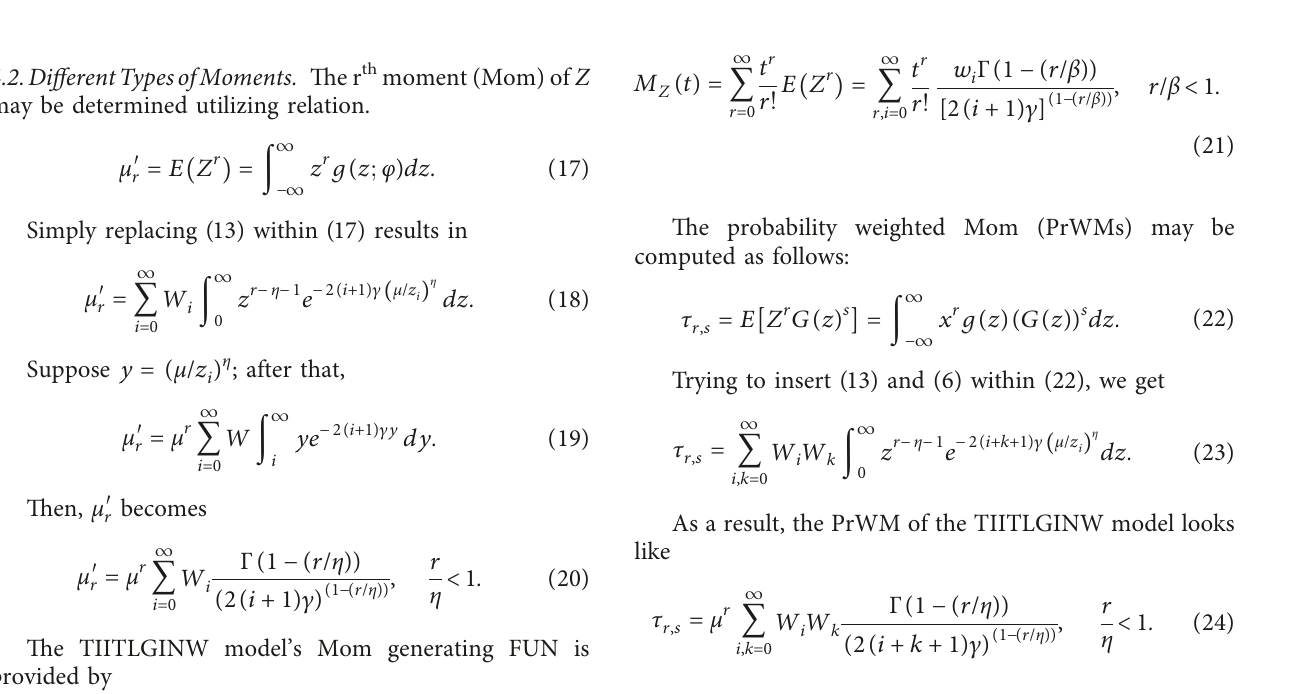
Figure 1: TIITLGINW pdf graphs for appropriate parameter combinations.